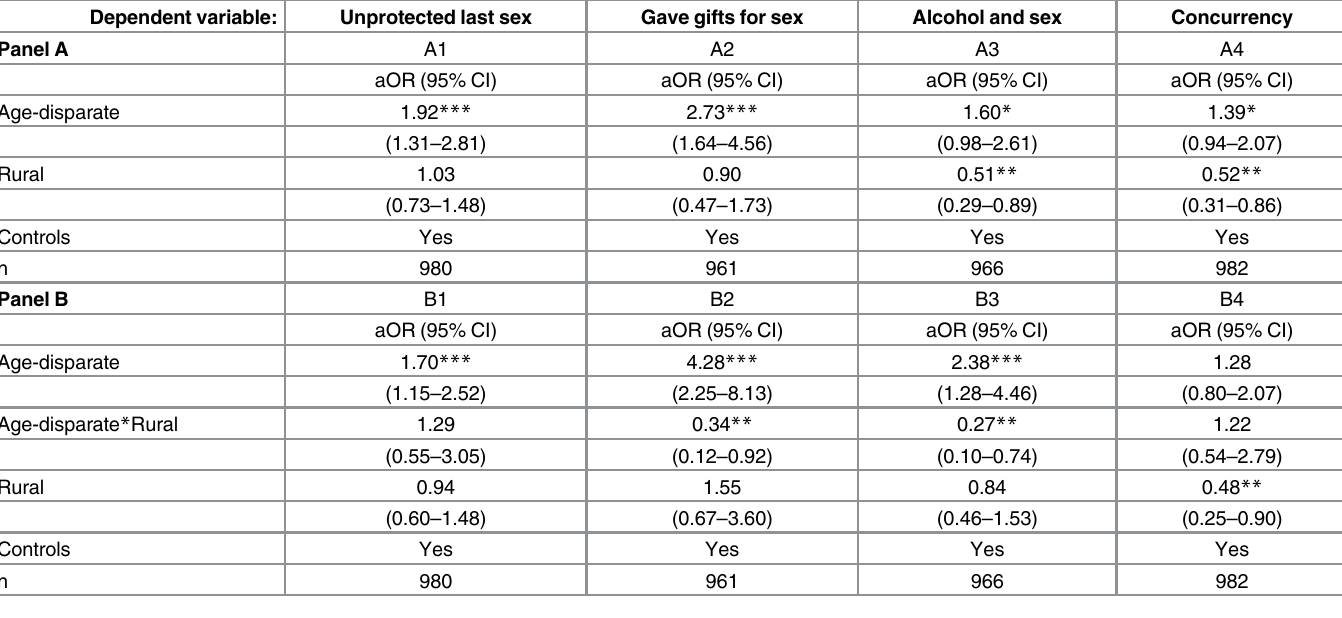
Table 3. Multiple logistic regression models of sexual behaviours reported by men in partnerships with 16 to 24 year old women. Dependent variable: